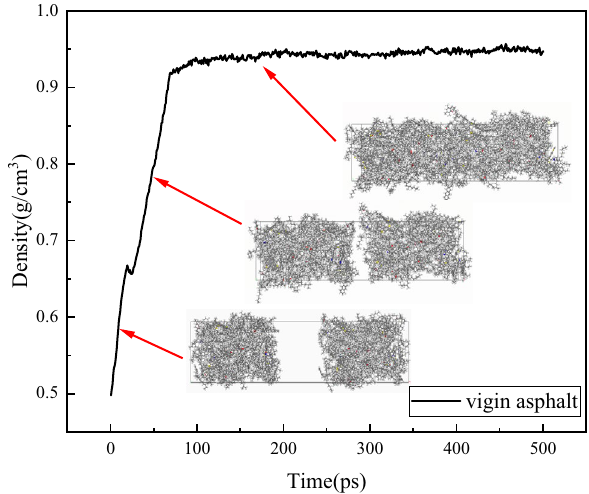
Figure 8. The model conformation during the self-healing process.